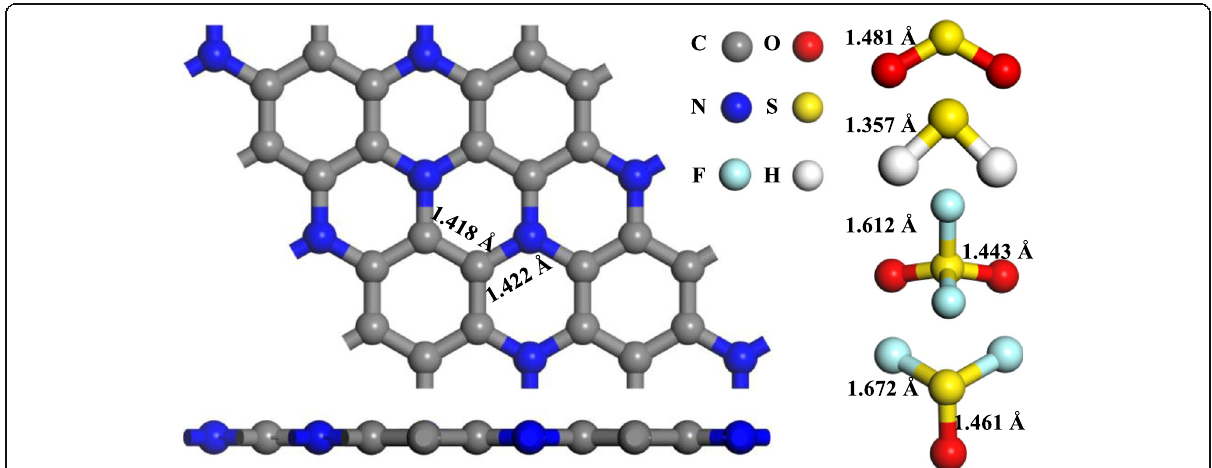
Fig. 1 Optimized structure of C 3 N monolayer, H 2 S, SO 2 , SOF 2 , and SO 2 F